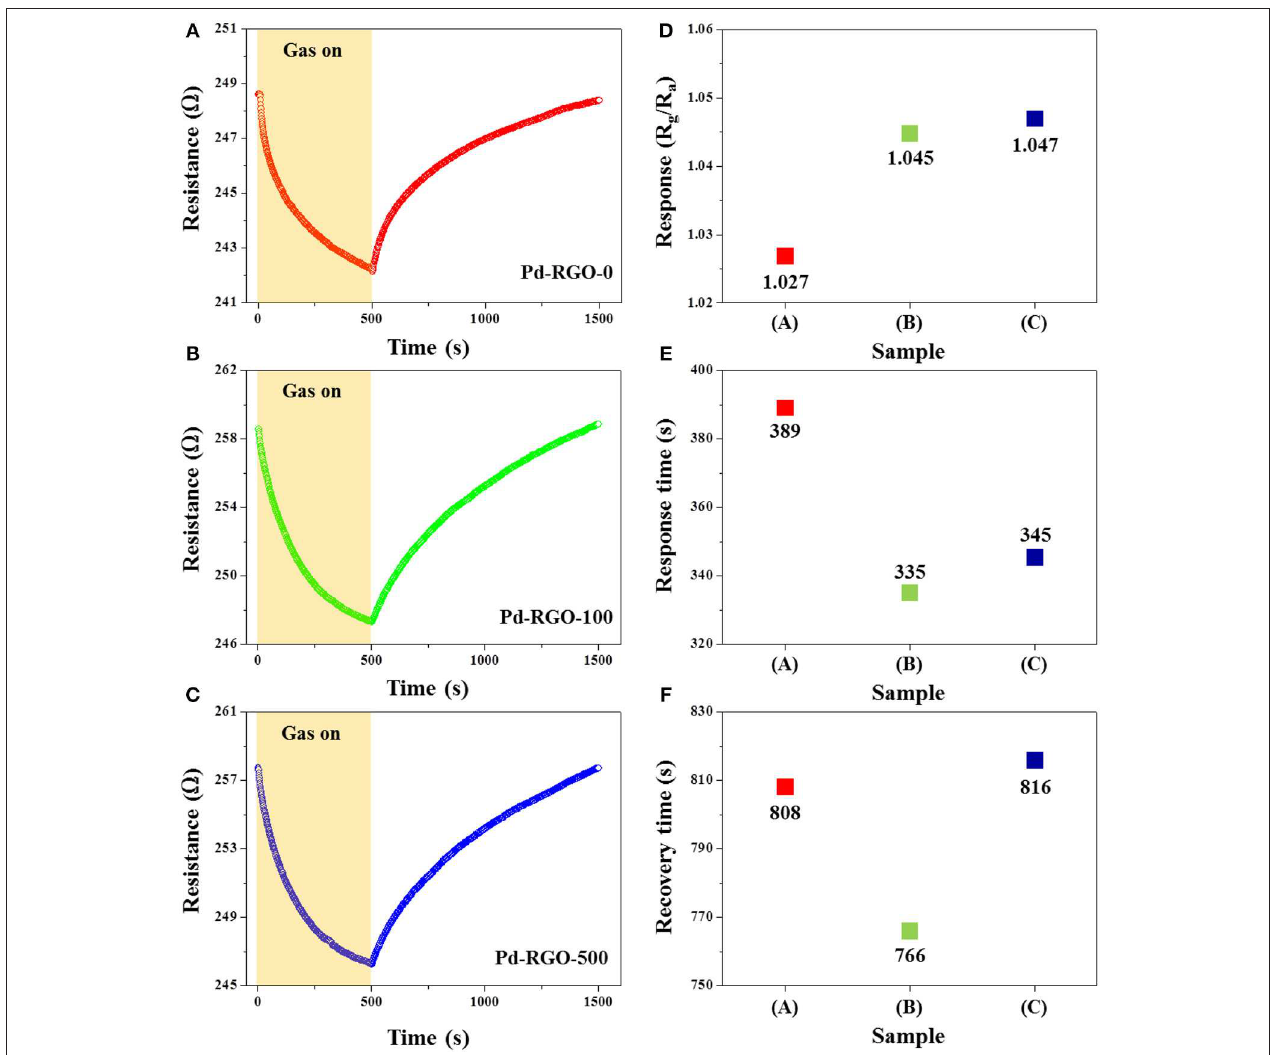
FIGURE 8 | Dynamic resistance curves of (A) the Pd-RGO-0 sensor, (B) Pd-RGO-100 sensor, and (C) Pd-RGO-500 sensor to 10 ppm NO 2 gas at room temperature. (D) Response of each gas sensor to 10 ppm NO 2 gas. (E) Response time and (F) recovery times of the gas sensors to 10 ppm NO 2 gas at room temperature.